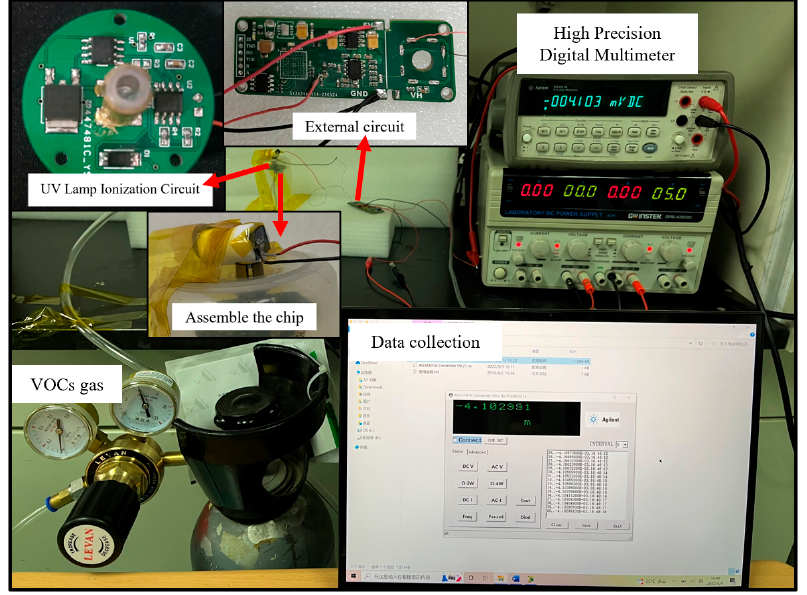
Figure 10. Actual test system.